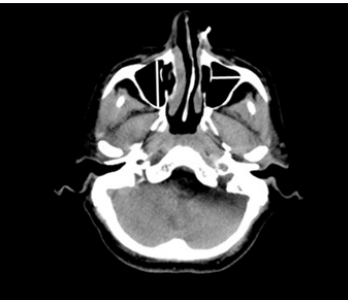
Fig. 1: vertical line shows the length of maxillary sinus; horizonatal line shows the width of maxillary sinus.